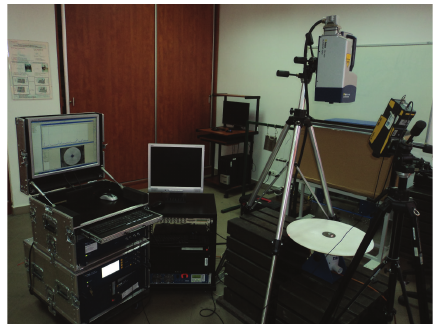
Figure 5: Experimental setup for identification of stiff inclusion in composite circular plate.